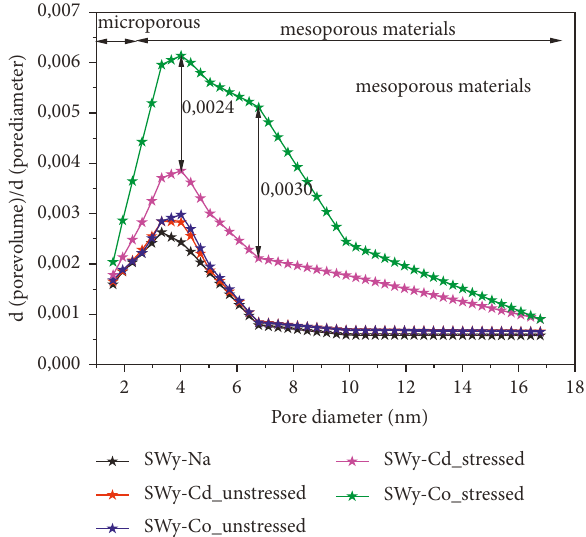
Figure 10: The derivative pore size distribution